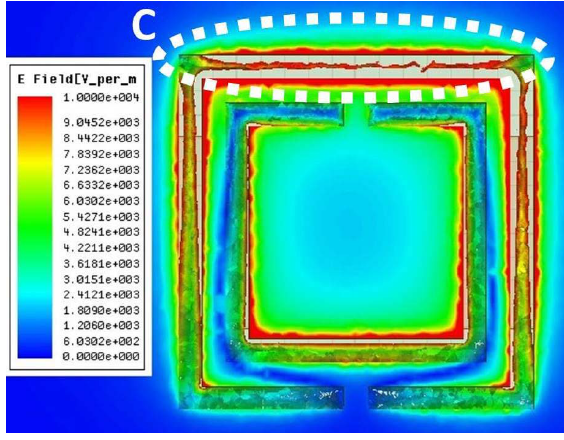
Total electric field distribution on a CSRR at the resonance frequency of a 3 -mm CSRR. The red color indicates the highest current magnitude.